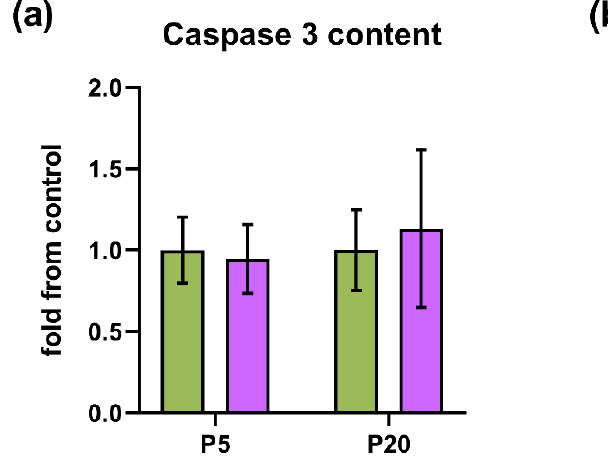
Figure 6. Effects of maternal hyperhomocysteinemia on caspase-3 and p38 MAPK in the hippocampus of the pups on P5 and P20. PHHC, prenatal hyperhomocysteinemia. ( a ) Band density of p35 caspase-3 content in the hippocampus of rats on P5 and P20 in the control ( n = 12–13) and PHHC ( n = 13–15) groups determined by densitometry analysis. ( b ) Caspase- 3 activity in the hippocampus of the rats on P5 ( n = 6–8) and P20 ( n = 10) in the control and PHHC groups. Samples were run in duplicate. ( c ) The ratio of phospho-p38 (p-p38) and total p38 MAPK content in the hippocampus of the rats on P5 ( n = 4–5) and P20 ( n = 4–5) in the control and PHHC groups determined by densitometry analysis. ( d ) Representative Western blots are shown for each condition. Western blot data for each age are normalized to the appropriate control group for comparison. Data are presented as mean ± SD. Significance of difference between the PHHC and control groups were determined by the Student’s t -test (* p ≤ 0.05). 3.7. p38 MAPK Content The p38 MAPK phosphorylation in the hippocampus of PHHC rats increased on P5 (2.44-fold, the Mann–Whitney U -test) (Figure 6c), despite the fact that the total levels of p38 MAPK were not altered (Figure 6d). Furthermore, the ratio of phospho-p38 (p-p38) and total p38 MAPK content was also elevated in the PHHC group of pups on P20 (1.77- fold, the Mann–Whitney U -test p ≤ 0.05) (Figure 6c). 4. Discussion To identify the possible causes of the behavioral changes observed previously in the rat offspring after PHHC [1,7], we investigated the glial cells and neurons in the hippo- campus using immunofluorescence staining. Microglia are integral resident central nerv- ous system immune cells [24,25] and excessive and prolonged activation of microglial cells